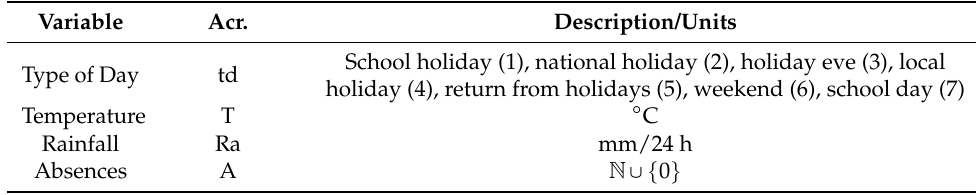
Table 1. Variables involved in the school absences prediction problem.